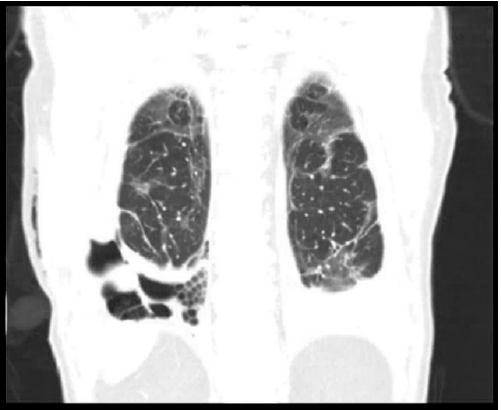
Figure 1. Computed tomography, coronal plane. ( a ). April 2020. Level of trachea bifurcation. Bilateral consolidations and ground glass opacities during active SARS-CoV-2 infection. ( b ). September 2020. Level of trachea bifurcation. Bilateral residual ground glass opacities. ( c ). September 2020. Level of thoracic vertebrae. Right sided loculated pleural effusion, pleural empyema, and trapped lung.